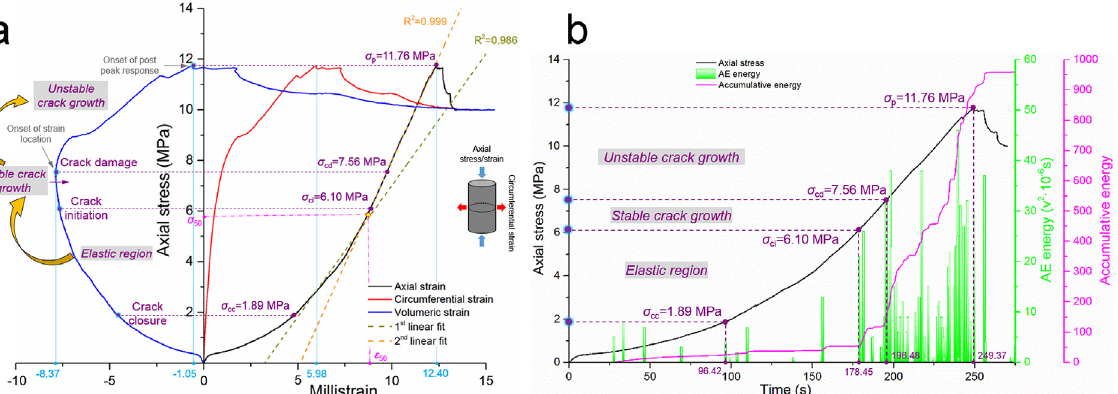
Fig 7. Test results of intact coal No. 2. (a) Relationship between the axial/circumferential/volumetric strain and axial stress under uniaxial compression. (b) Relationship between the time and axial stress/AE energy/accumulative AE energy under uniaxial compression.